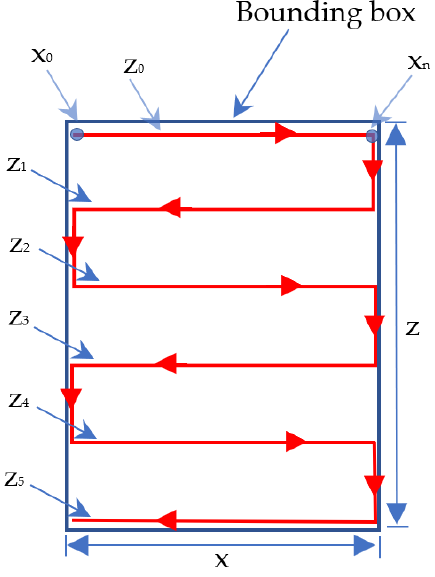
Figure 10. Fast scanning image process path.